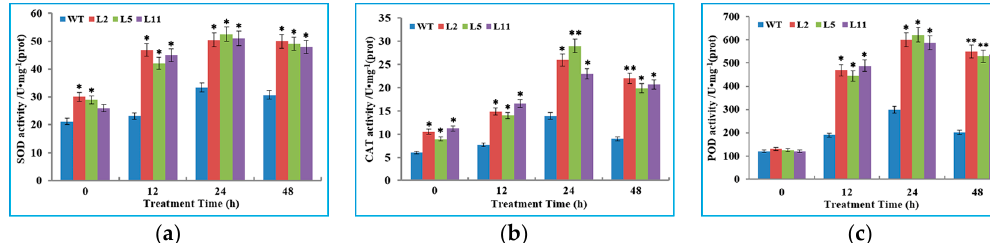
Figure 6. Analysis of antioxidative enzyme activity in the WT and transgenic lines (L2, L5 and L11) undergoing cold stress (2 °C) at different time points: ( a ) superoxide dismutase (SOD), ( b ) catalase (CAT) and ( c ) peroxidase (POD). Data are the mean ± SE of three biological replicates; asterisks indicate significant difference (* p < 0.05, ** p < 0.01) in comparison with wild type.